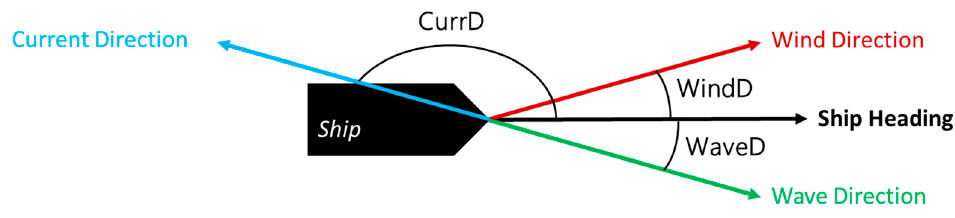
Figure 6. Directional feature transformation.